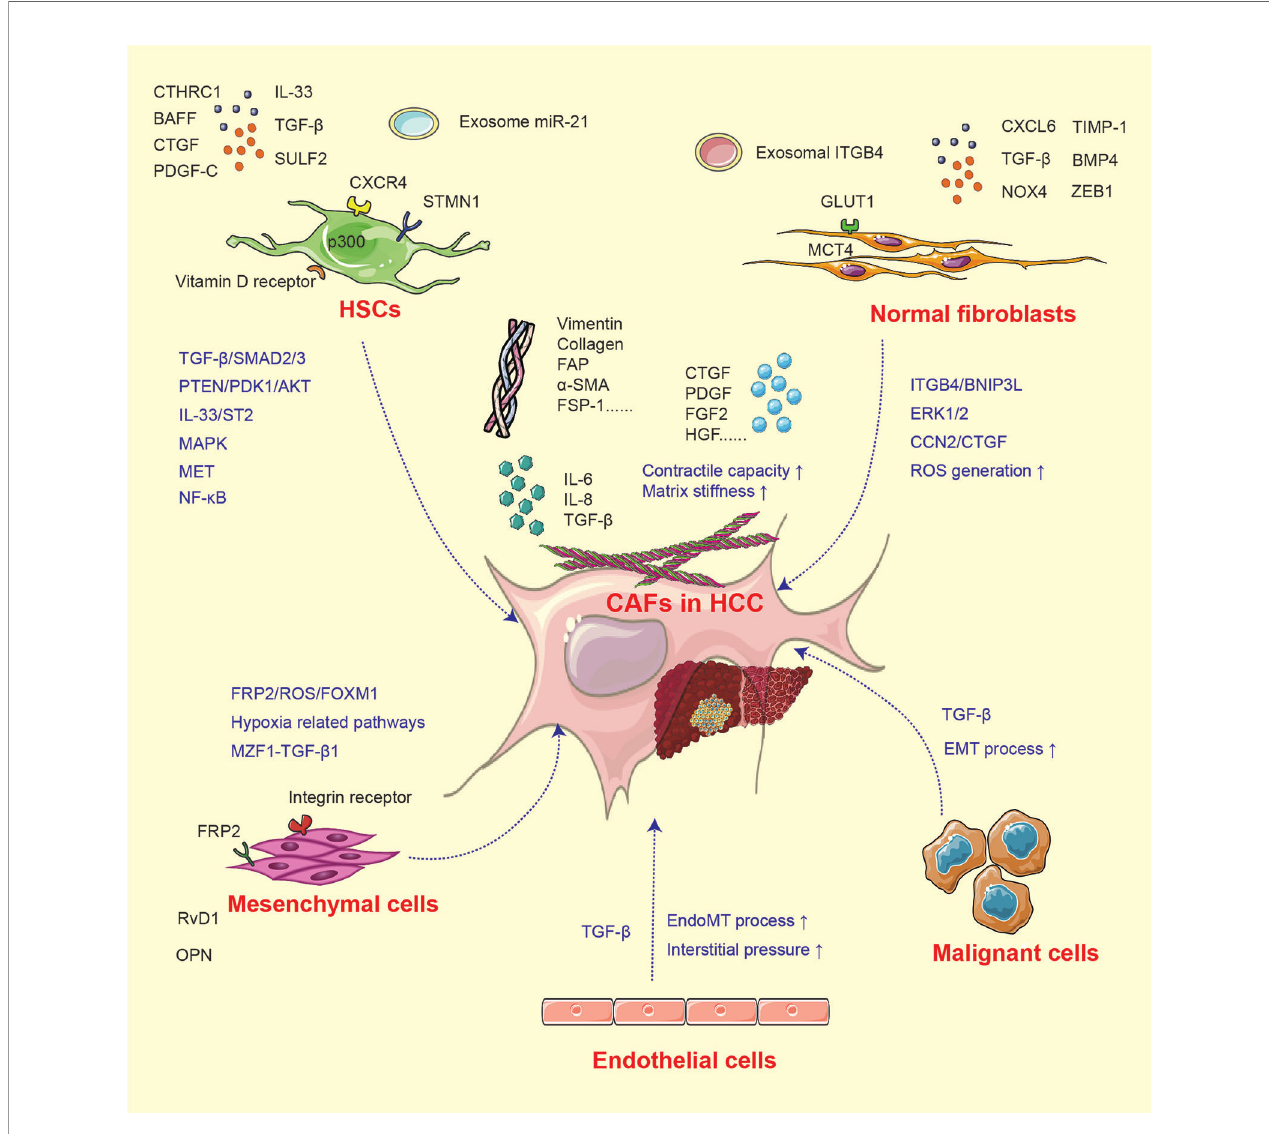
FIGURE 1 | The activation of CAF from heterogeneous